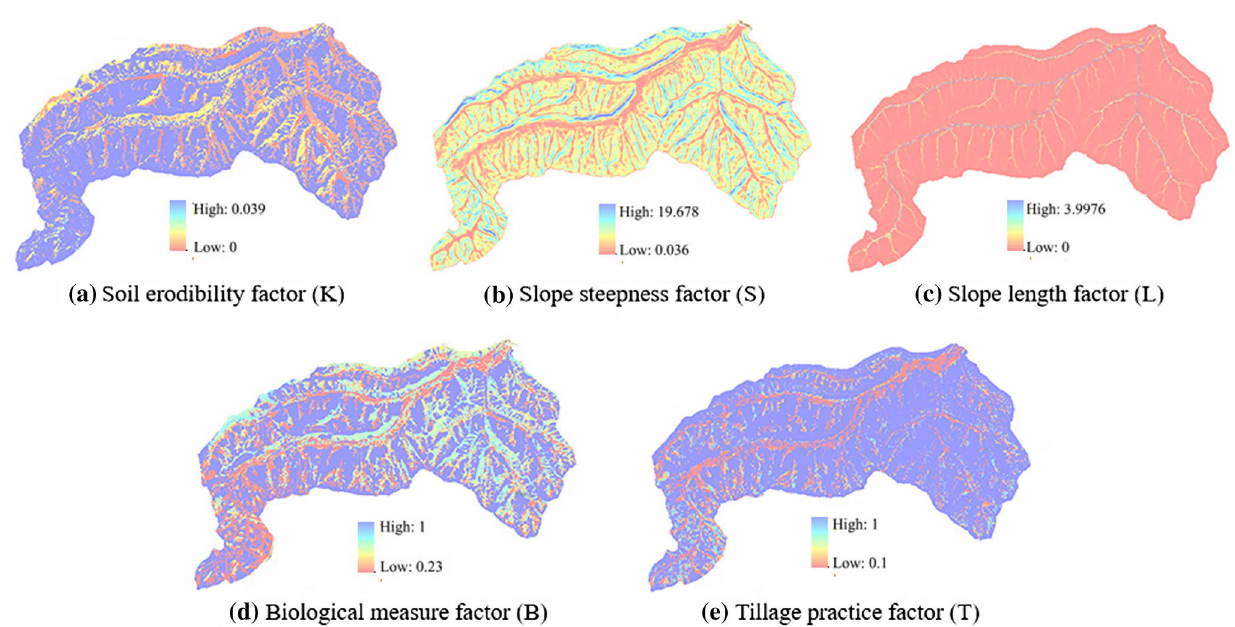
Fig. 9 Spatial distribution of soil loss model